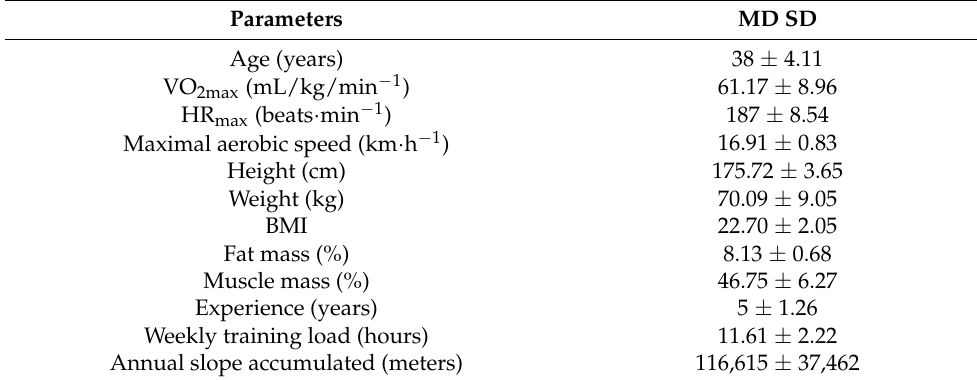
Table 1. Characteristics of population included ( n =